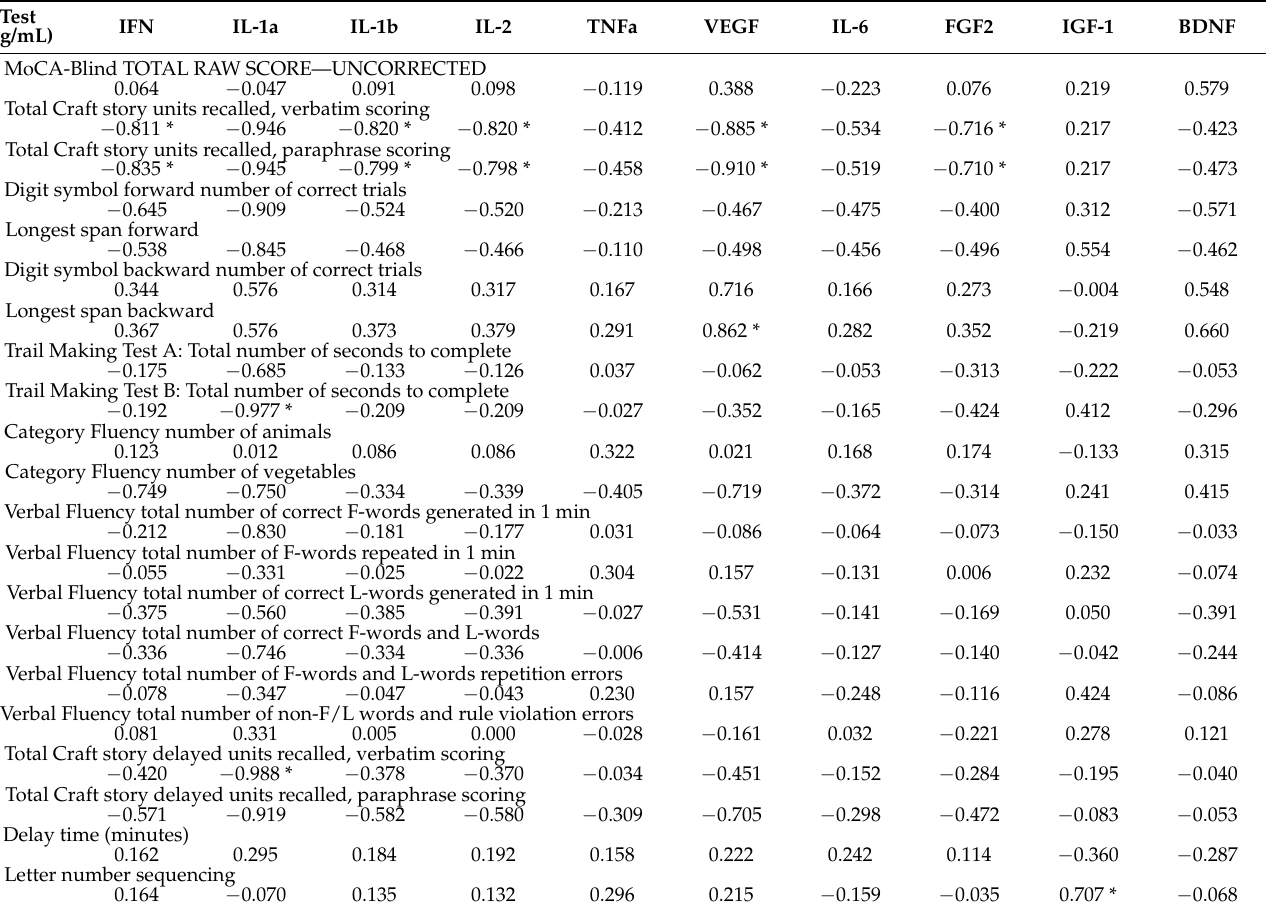
Table 10. Pearson correlations for change from baseline between biomarkers and cognitive